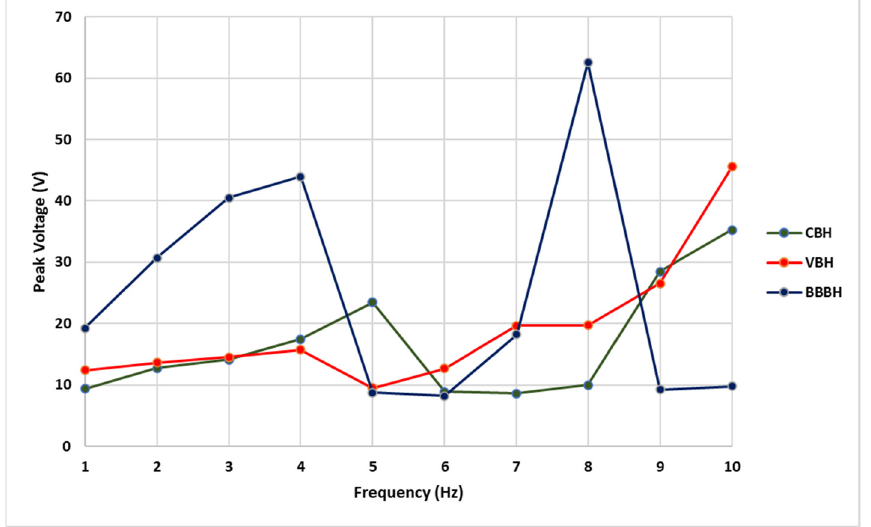
Figure 7. Output voltage of CBH, VBH, and BBBH under excitation frequency of 1 Hz–10 Hz under 1 g acceleration.